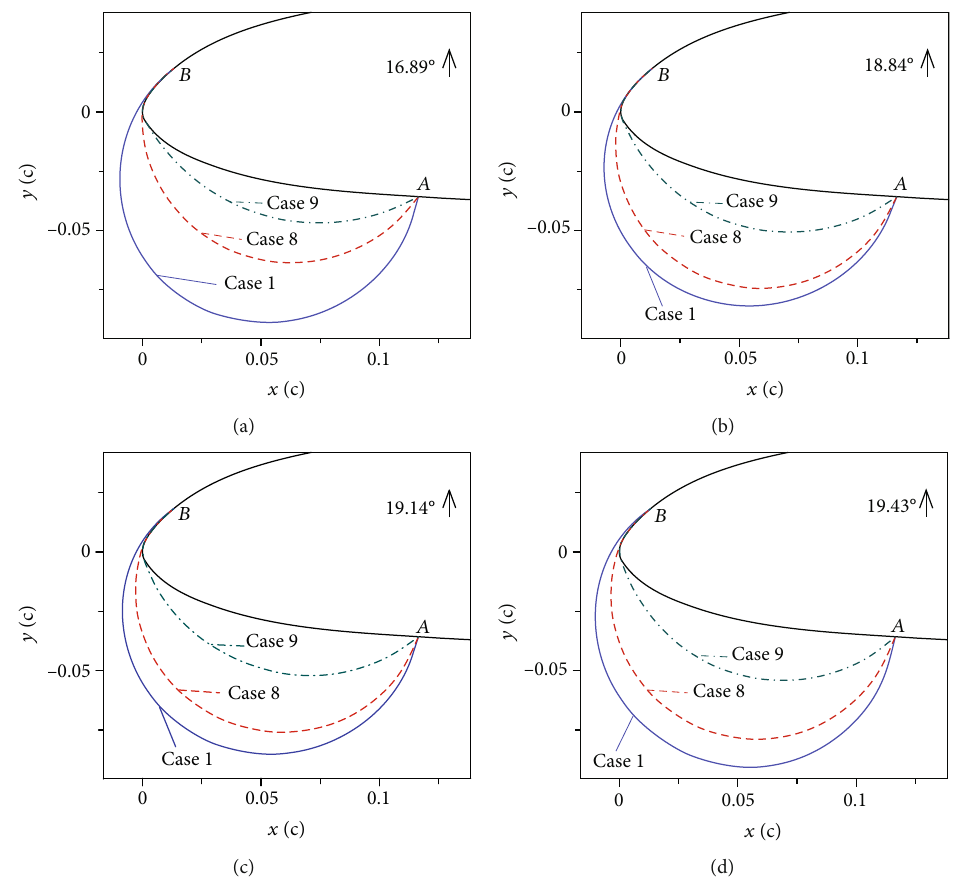
Figure 34: Comparison of ILE shapes at di ff erent angles of attack upstroke in airfoil frame of